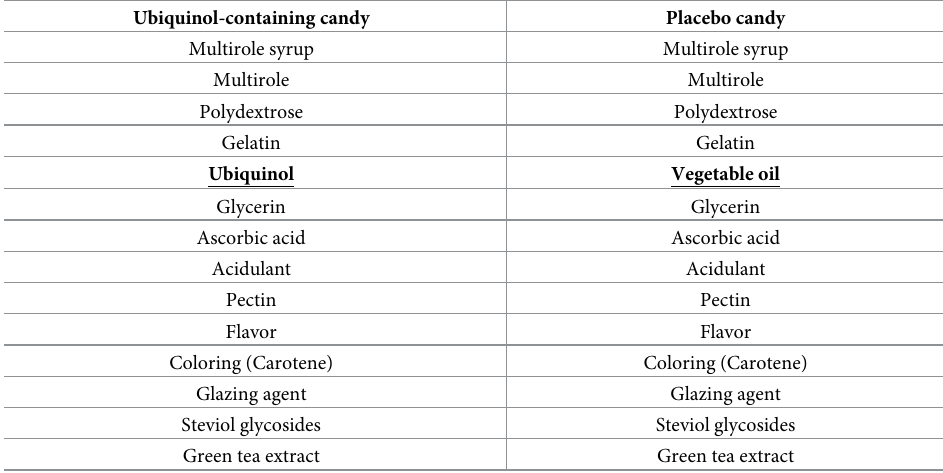
Table 1. Composition of the